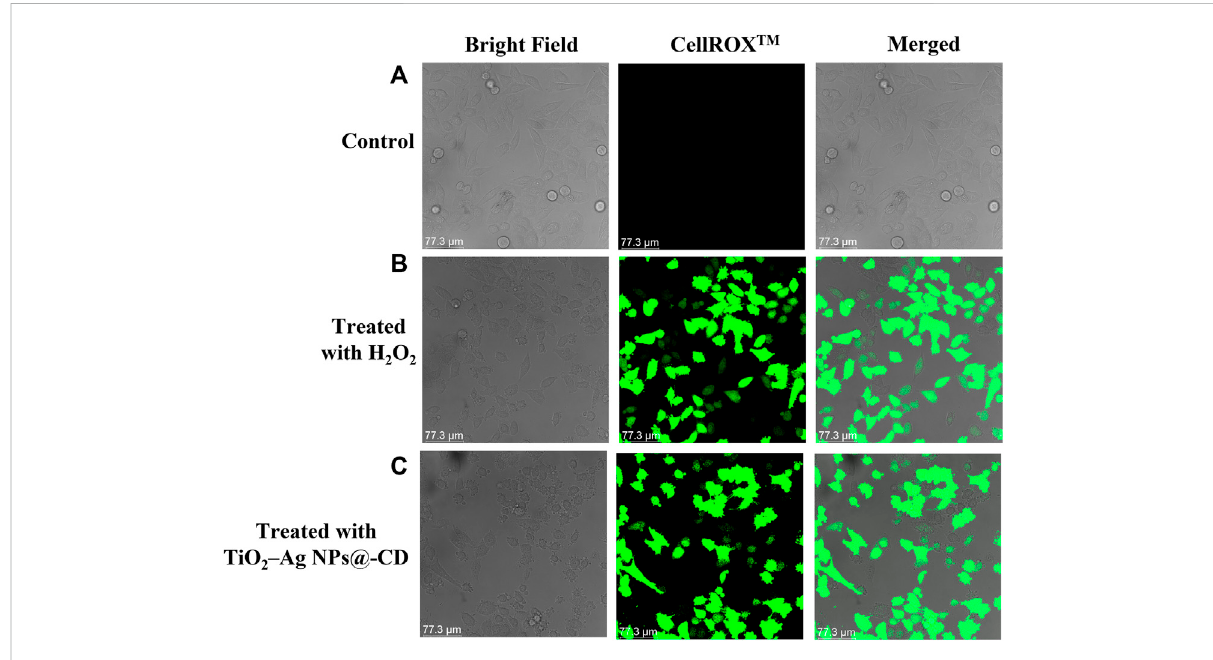
FIGURE 4 CLSM images of ROS-induced oxidative stress in (A) untreated (control), (B) treated HeLa cells with H 2 O 2 , and (C) TiO 2 -Ag NPs@-CD.